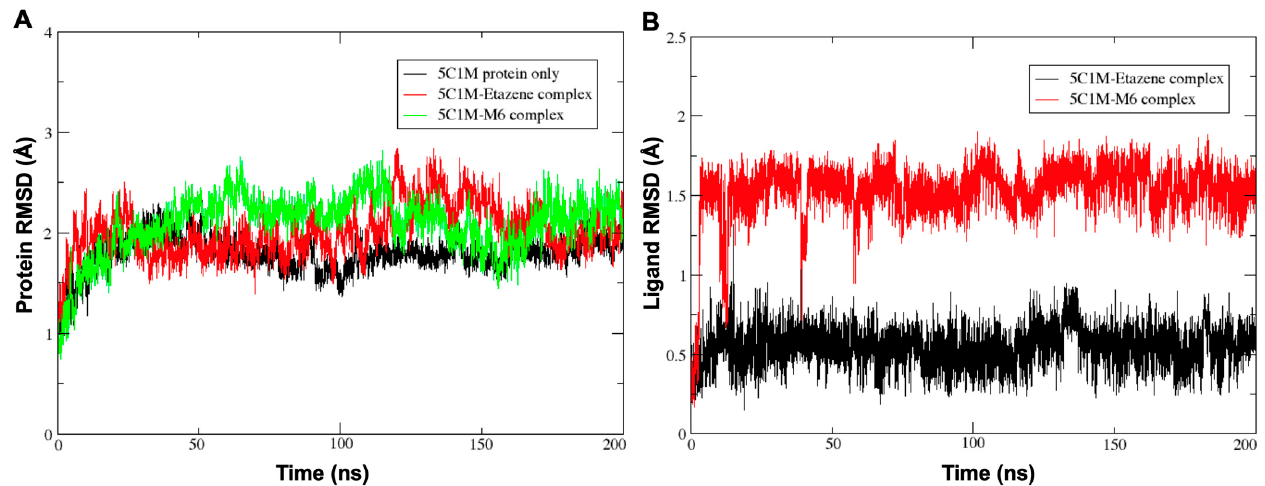
Figure 5. ( A ) The protein RMSD plot for C α atoms of the protein MOR (PDB ID: 5C1M) only and MOR ‒ etazene and MOR ‒ M6 complexes; and ( B ) the ligand RMSD plot for ligand – heavy atoms for MOR ‒ etazene and MOR ‒ M6 complexes (PDB ID: 5C1M) for the reference frame at 0 ns.